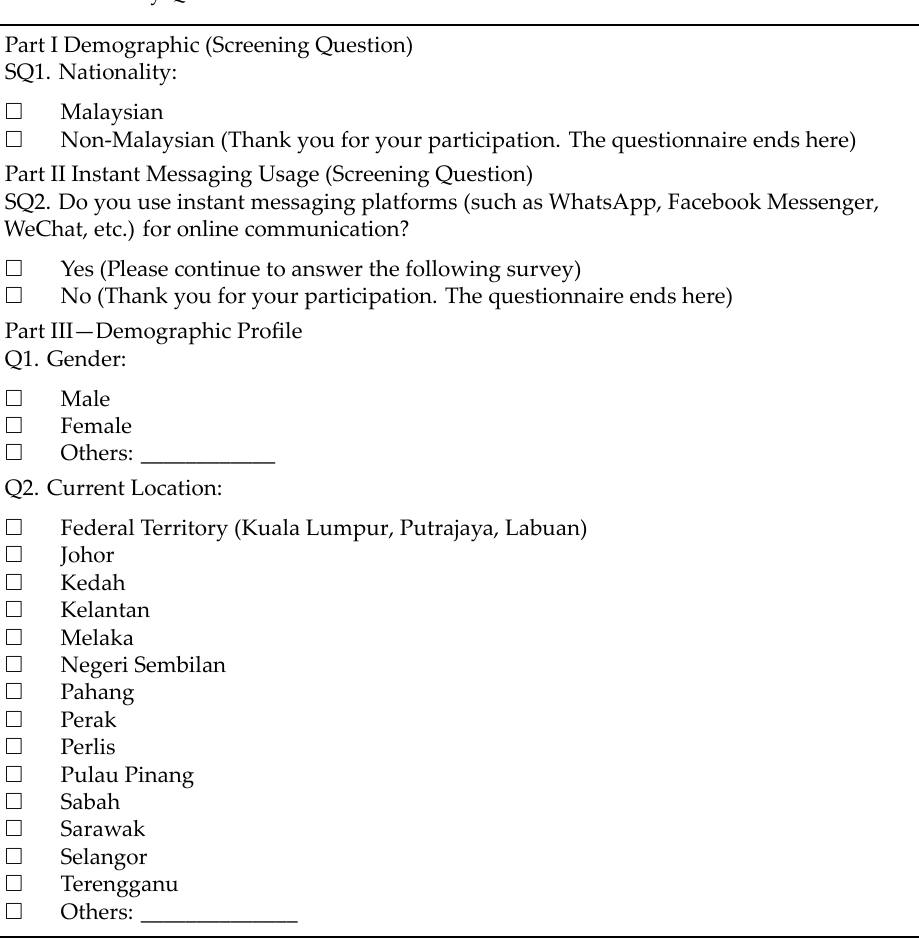
Table A1. Survey